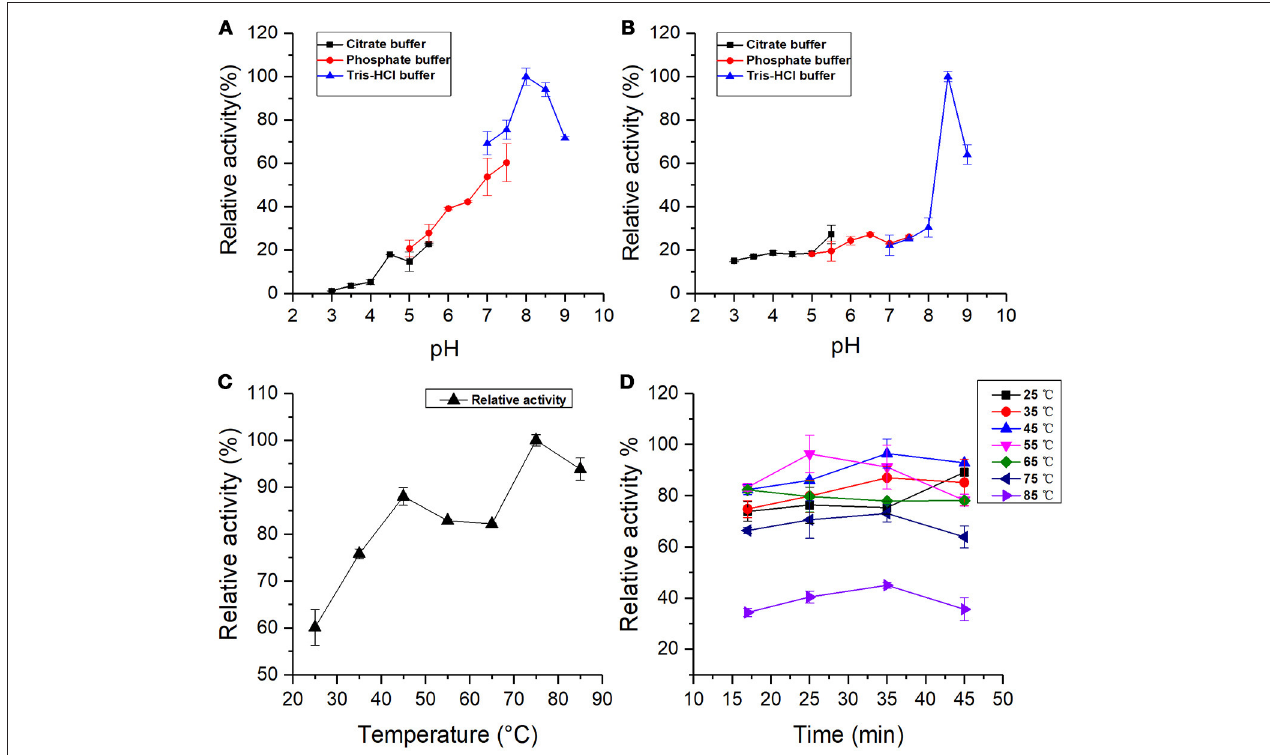
FIGURE 4 | (A) pH stability: BRP activity incubated at different pH values for 36h. (B) Optimal pH: BRP activity as a function of pH value. (C) Optimal temperature: BRP activity as a function of different temperatures from 25 to 85 ◦ C. (D) Temperature stability: BRP activity incubated at different temperatures. All data were the means ± SD of three independent experiments ( P < 0.05, n =